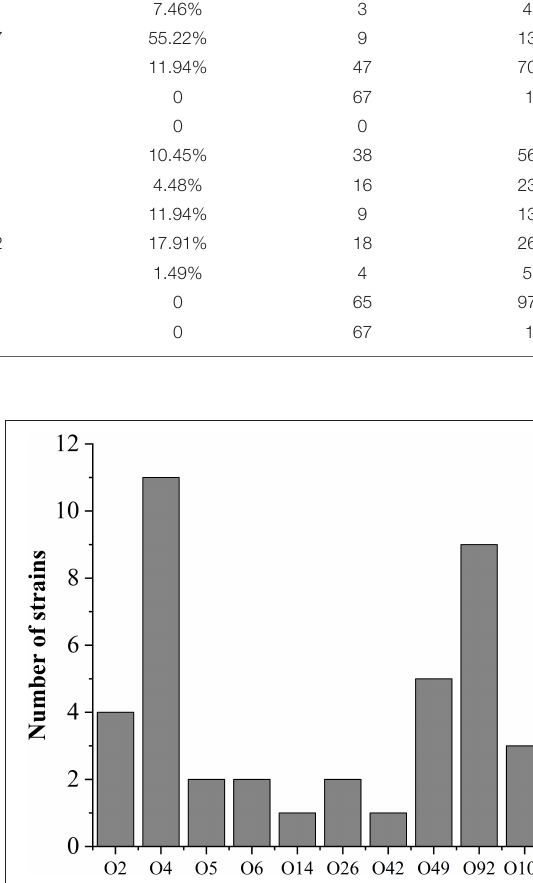
Number of susceptible isolates